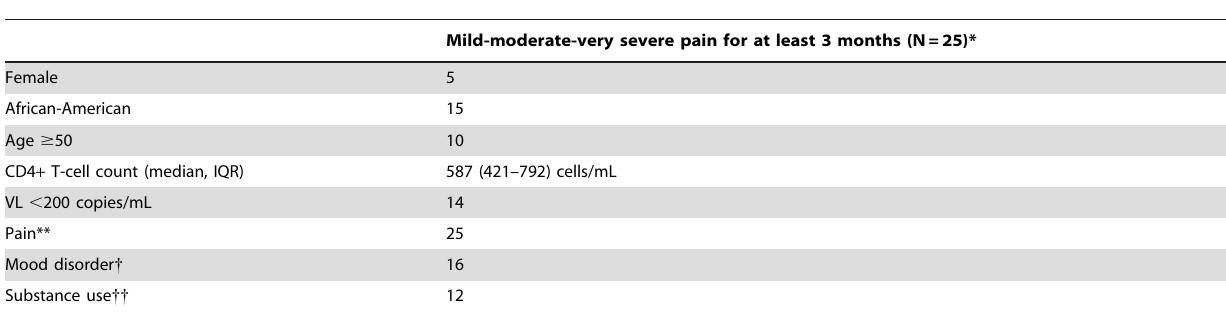
Table 2. Characteristics of Participants with Chronic Pain, as identified by the Brief Chronic Pain Screening Tool (BCPS) Results (N=